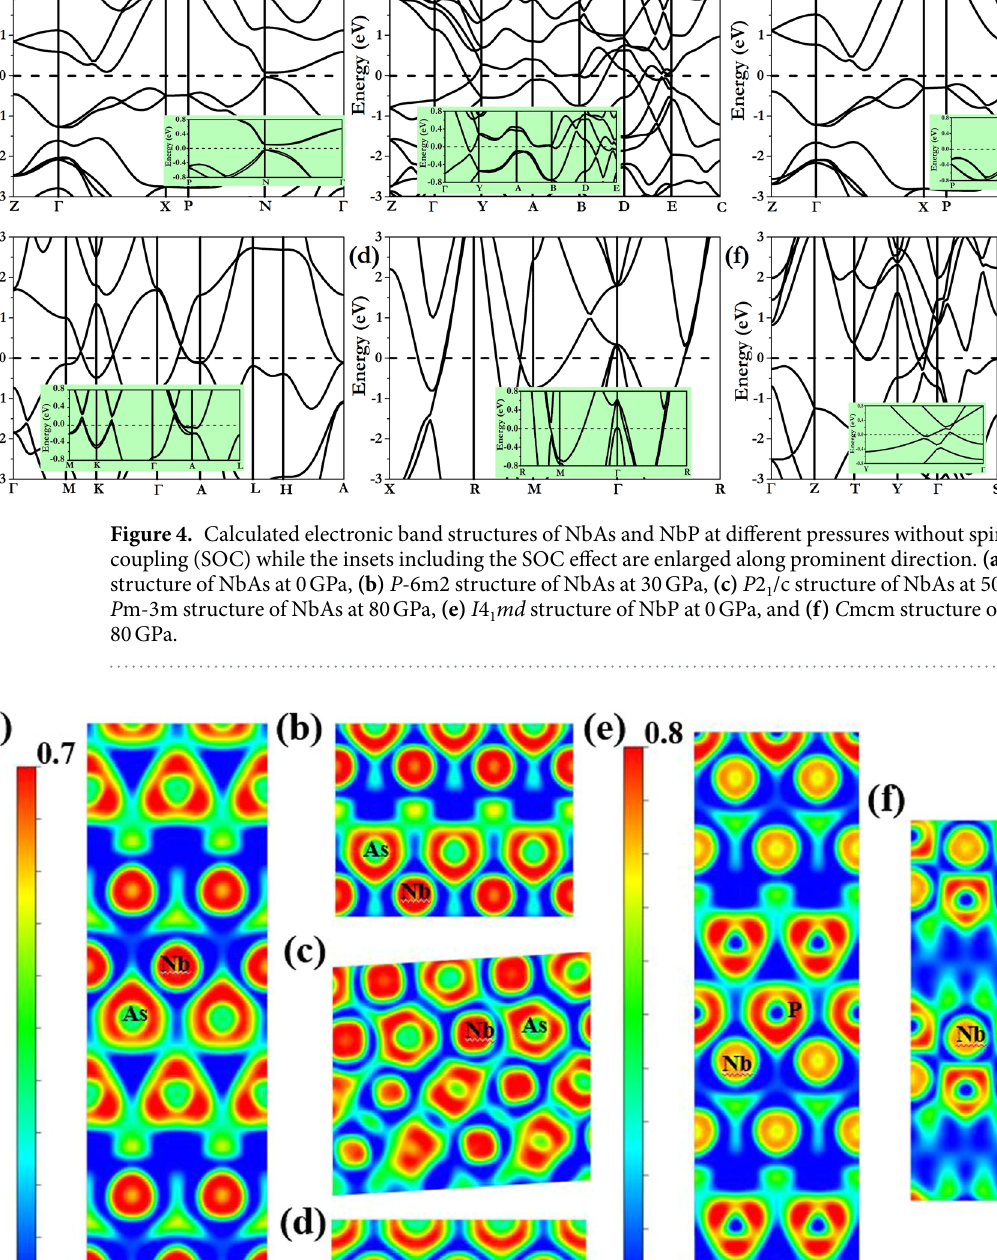
generations and 1500 random structures were generated in total. 60% of the previous generation with lower Gibbs free energy are kept while the rest 40% of current generation are generated randomly which guarantees the diversity of the structure pool. A bond characterization matrix is employed as a fingerprint technique to remove the degenerate structures which enhances the search efficiency. The underlying structural relaxations and all the